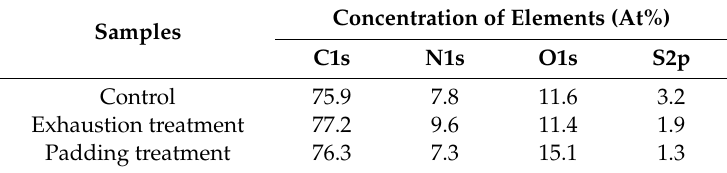
Table 3. Surface elements content of wool fiber after different processes.